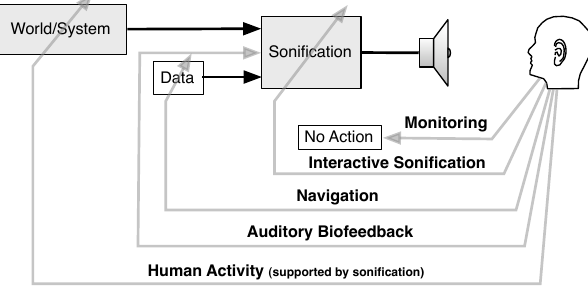
Figure 4: Illustration of Closed-Loop Auditory